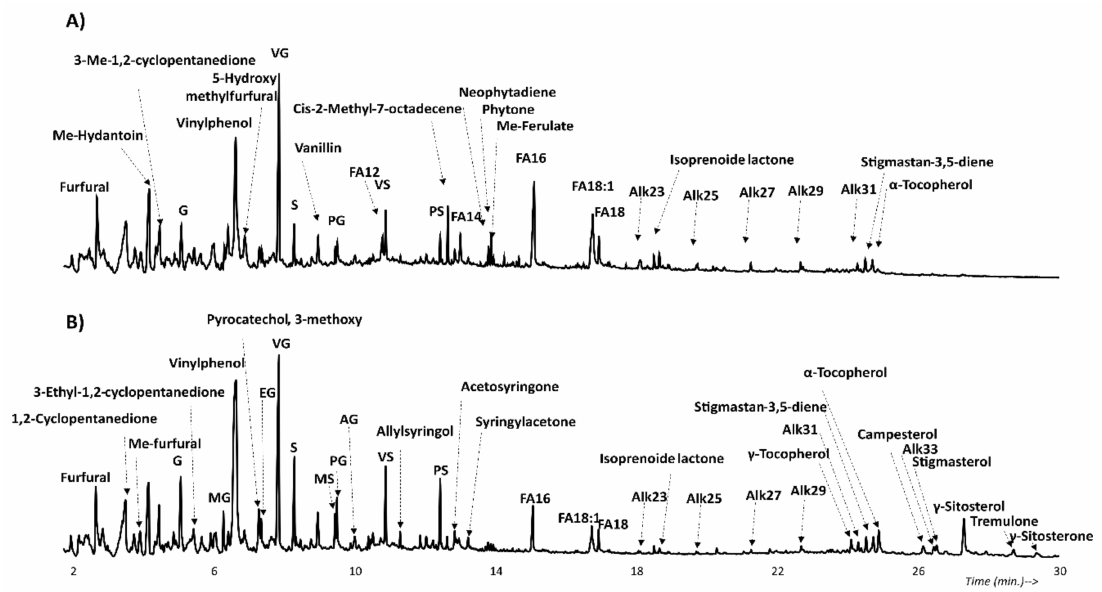
Figure 1. Example of Py-GC/MS chromatograms comparing the original biomass (T0; A ) and the compost material (T3; B ), with an indication of the most relevant